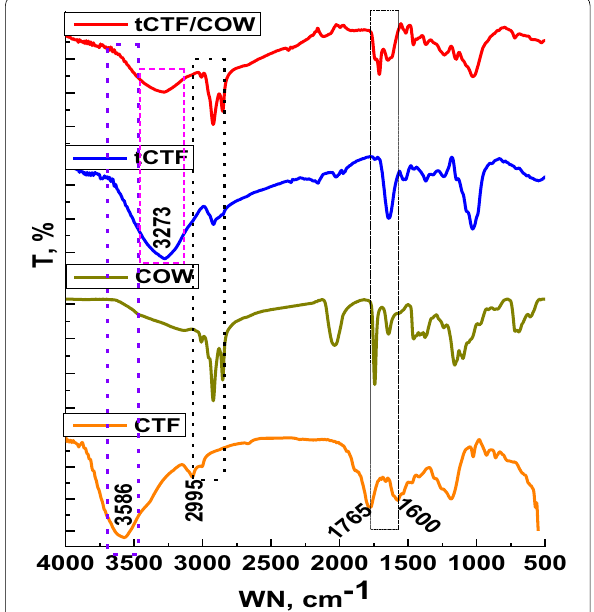
Fig. 1 FTIR spectra of raw CTF, tCTF, COW and